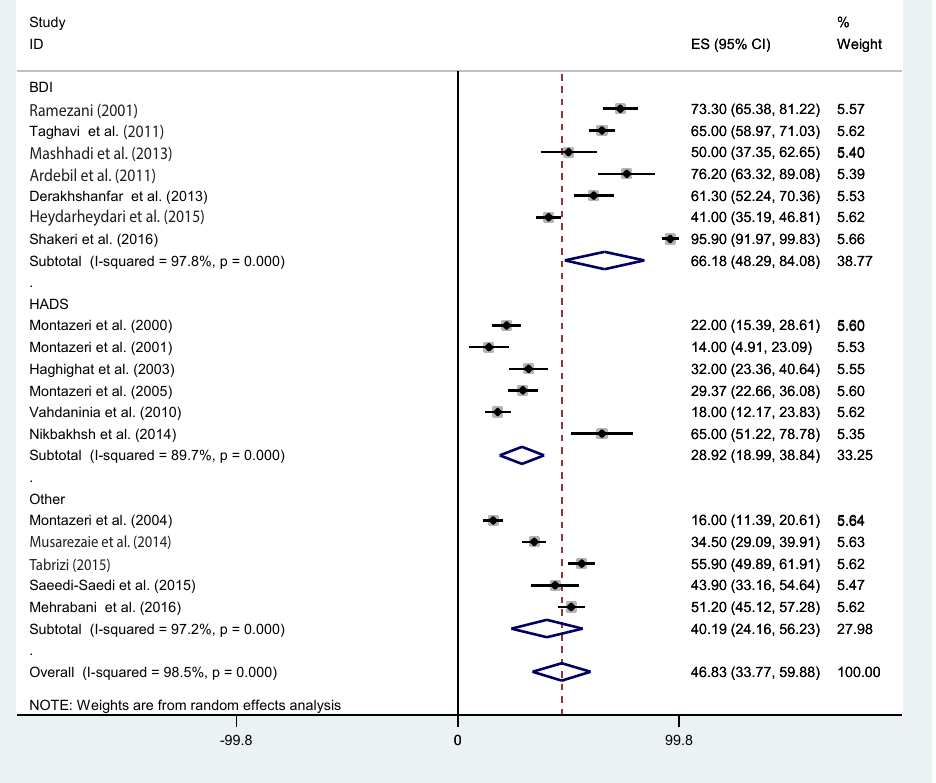
Figure 2. Forest plot of all 18 studies included in the meta-analysis based on the depression assessment tool used. ES, effect size (preva- lence); CI, confidence interval; BDI, Beck Depression Inventory; HADS, Hospital Anxiety and Depression